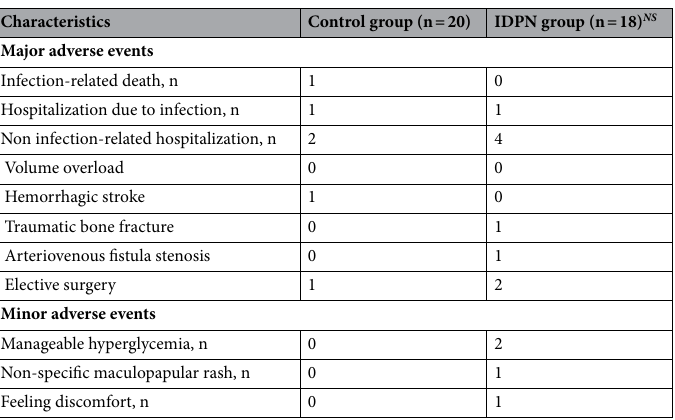
Table 4. Adverse effects of IDPN supplementation in both groups during the entire study period. NS, no statistical significant difference between control and intervention group ( p >